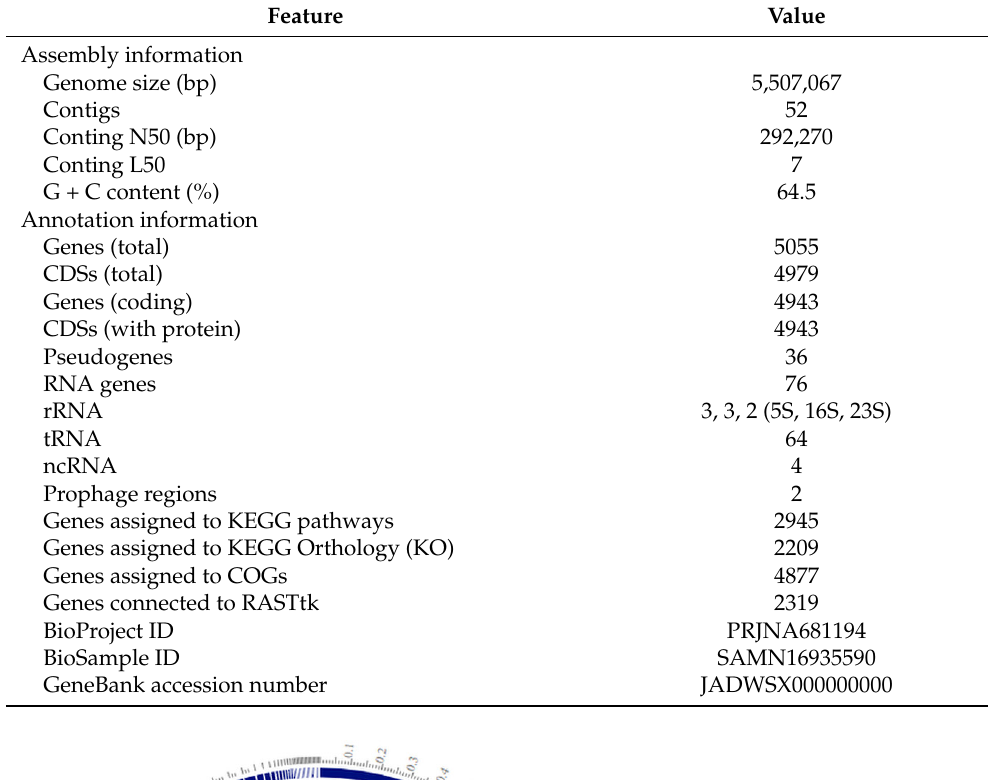
Table 3. Genome features of P. qingdaonensis ZCR6.